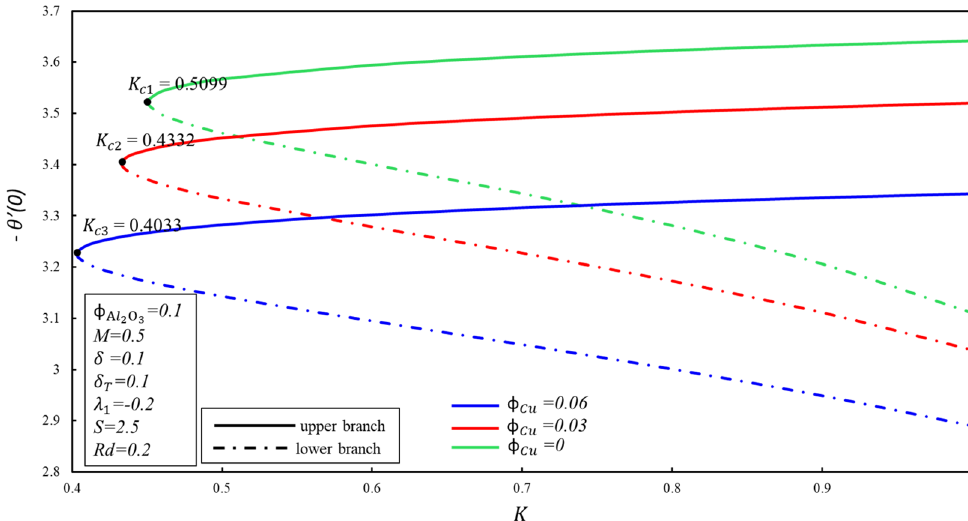
Figure 5. Behavior of